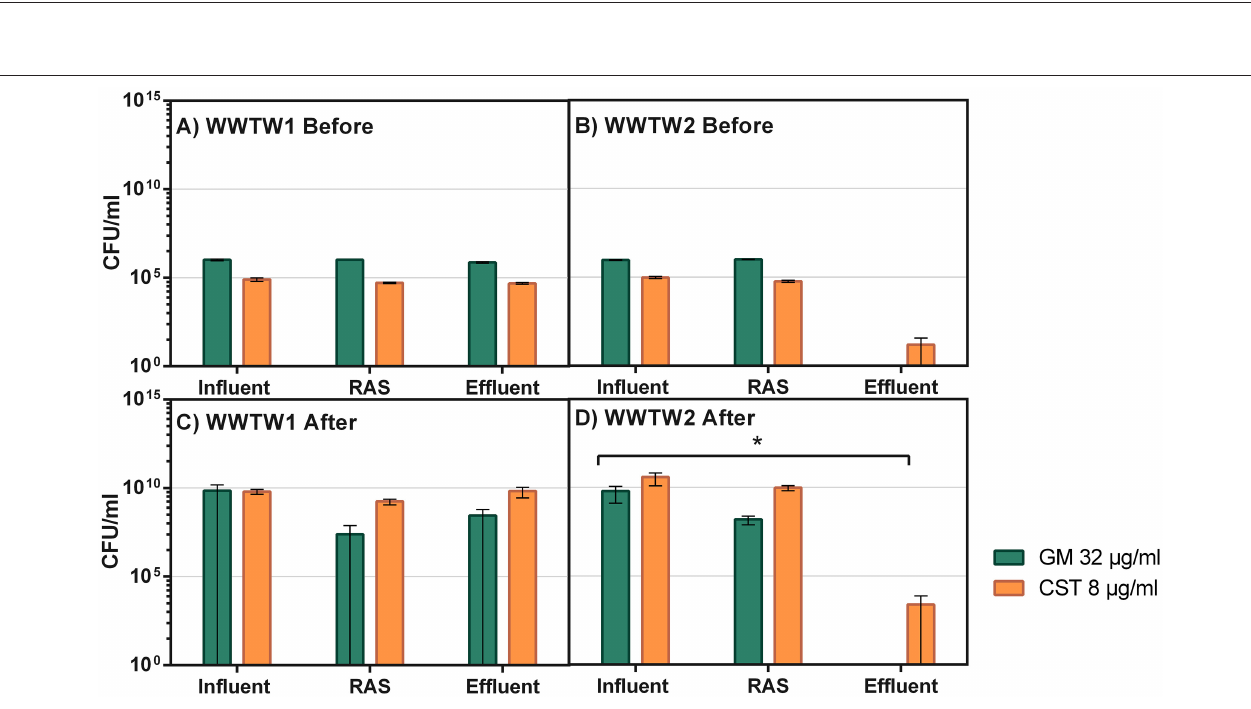
FIGURE 2 | Abundance of bacteria (OD600) in the presence of AMX (512 µ g/ml), SMX (512 µ g/ml), GM (32 µ g/ml), and CST (8 µ g/ml) from influent, RAS, and effluent samples in two WWTW [WWTW1: (A,C) ; WWTW2: (B,D) ] in sampling event 1 before (A,B) and after (C,D) being enriched in antibiotics. MacConkey media was used as a positive control (POS MAC) for CST while MHB was used as a positive control (POS MHB) for the other antibiotics. Significant differences ( p < 0.0.5) between matrices are indicated by the black bar and asterisk (*).